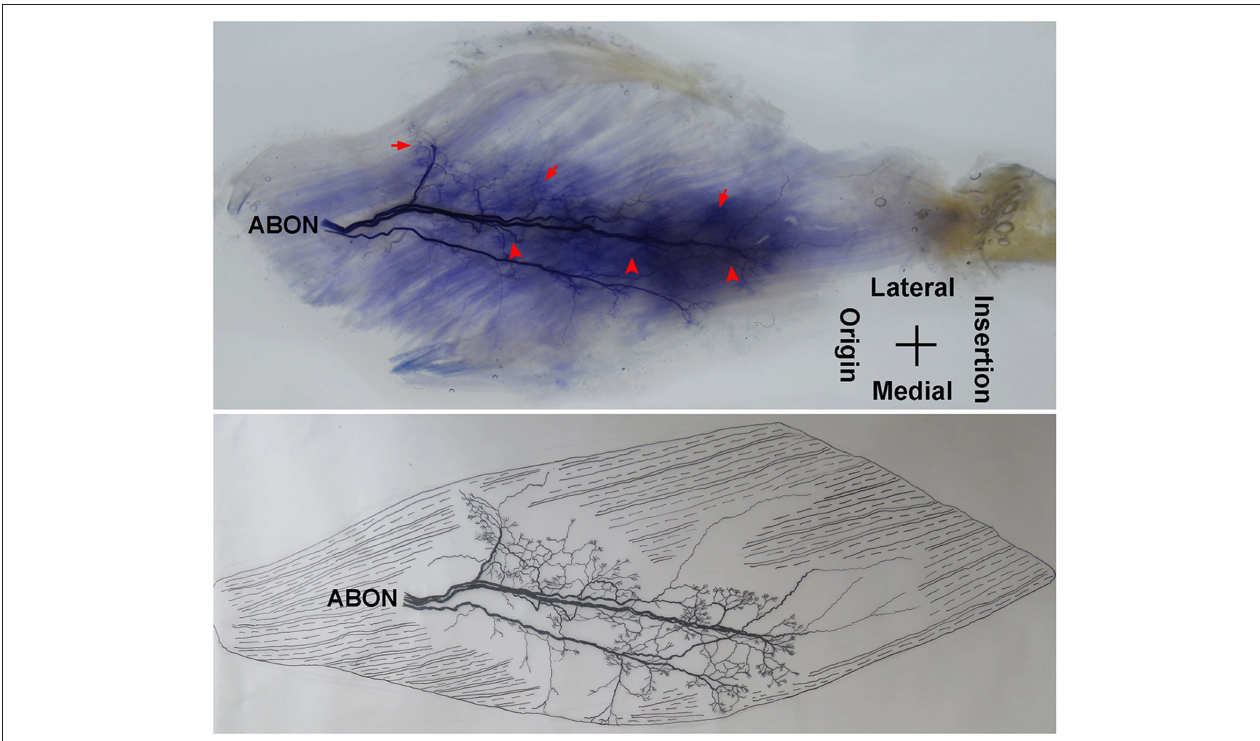
FIGURE 1 | Distribution of intramuscular nerves in the adductor longus (right, deep side). The arrow indicates the tree-branch-like terminal nerves, and the arrowhead indicates the grid-like terminal nerve junctions (ABON, anterior branch of the obturator